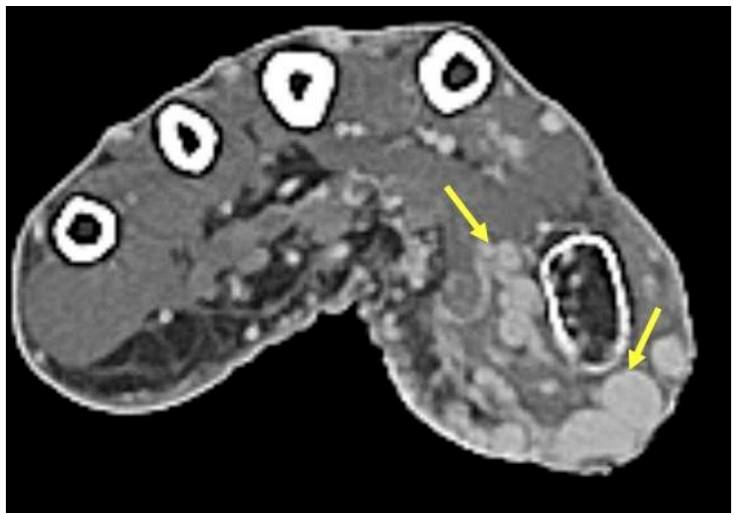
Figure 9. Arteriovenous malformation. Axial contrast-enhanced CT demonstrates numerous engorged vessels in the thenar eminence without a discrete mass in this high ‐ flow arteriovenous malformation.